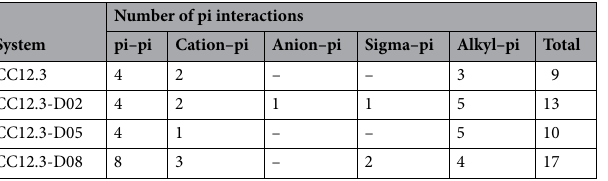
Table 4. Number of pi interactions of CC12.3, CC12.3-D02, CC12.3-D05, and CC12.3-D08 involved in SARS- CoV-2-RBD binding